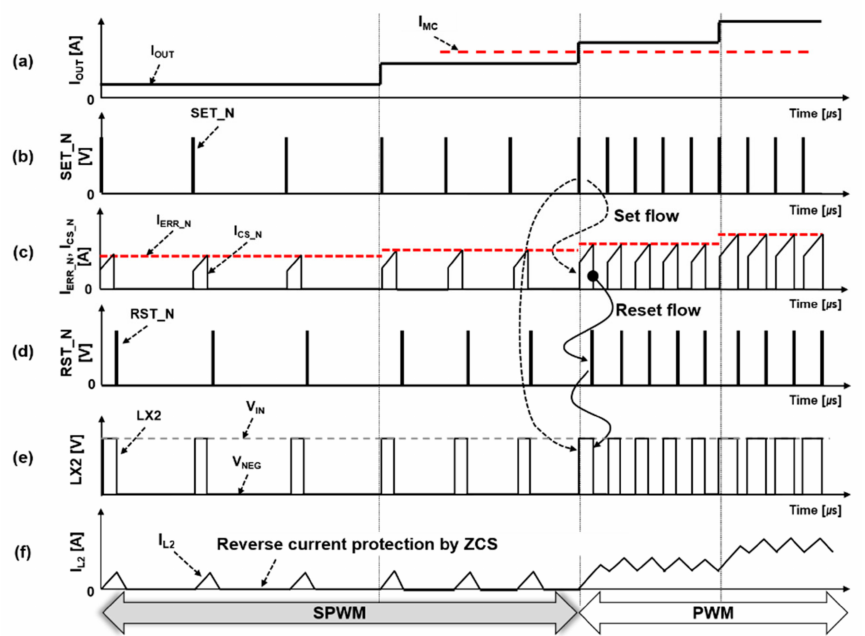
Figure 9. Timing diagrams of the proposed inverting buck–boost converter that uses the PWM–